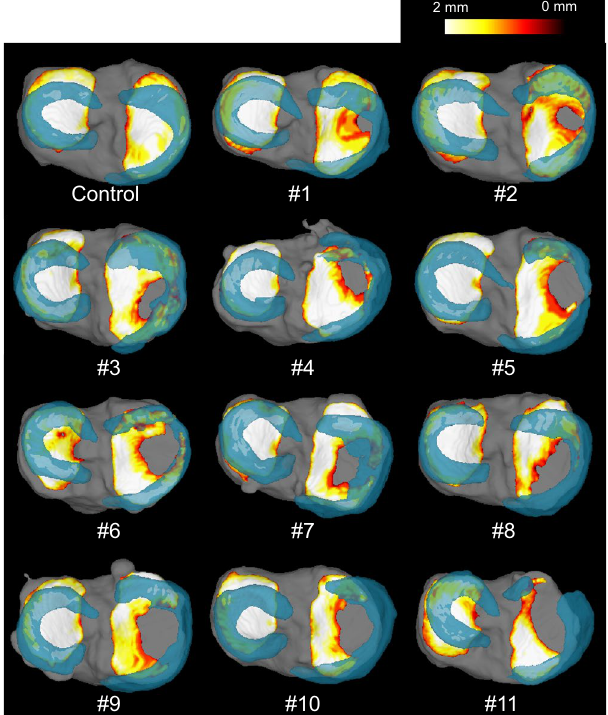
Figure 6. Superimposition of the meniscus on the cartilage thickness mapping of the tibia by 3D MRI. The thickness of the cartilage is indicated by color mapping, where white indicates a thickness ≥ 2 mm and the progression from yellow to red indicates thinning of the cartilage. The meniscus is shown in translucent blue, and the tibia bone is shown in